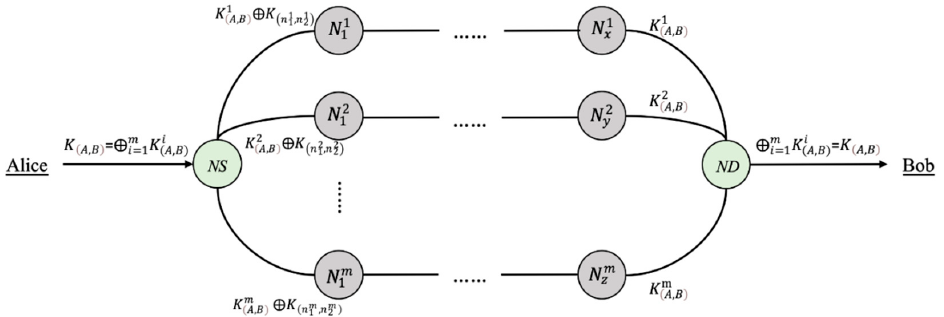
Figure 7. Session key transmission method using the multiple-path strategy.